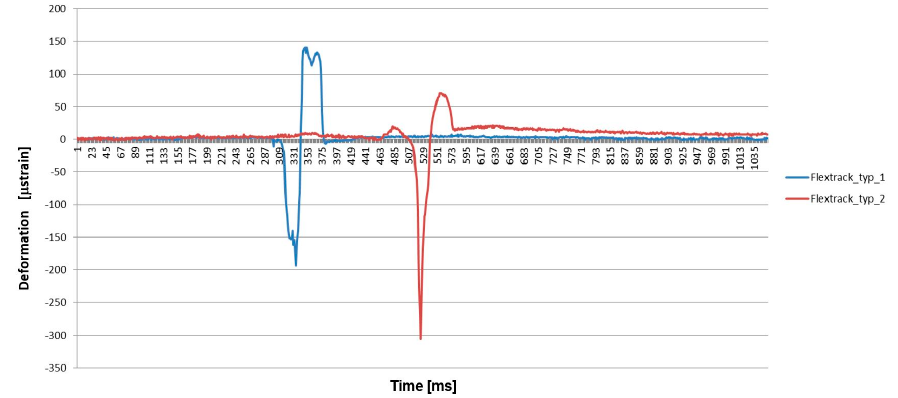
Figure 7. A course of the deformation value of the toothed segments of the Flextrack haulage system with the conveyor route curved in the horizontal plane.